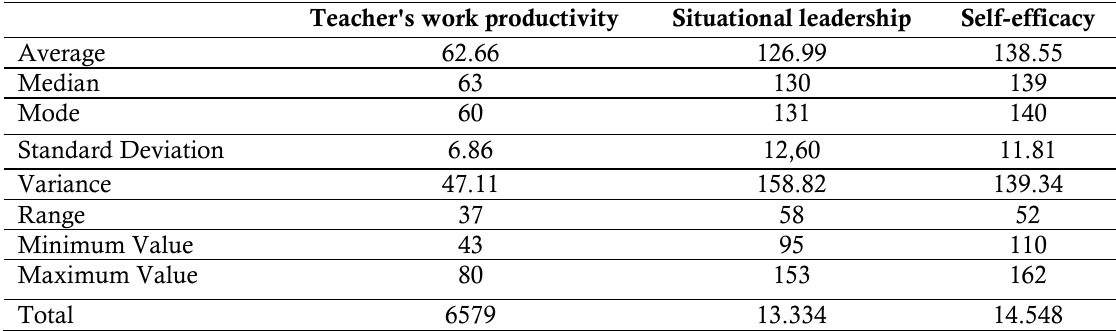
Table 1 . Results of descriptive